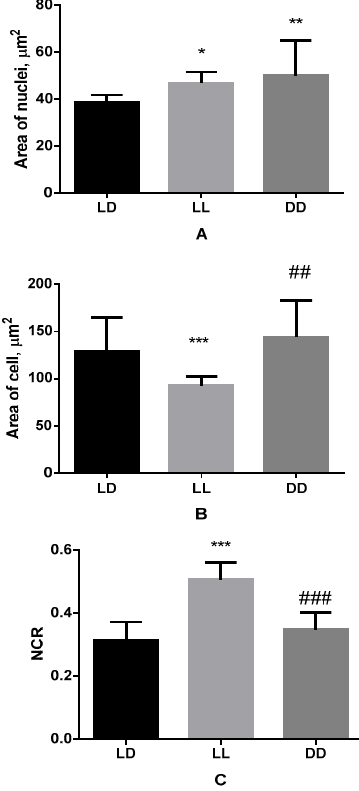
Figure 3. Influence of various lighting regimes on cell nuclei area ( A ), cell area ( B ) and nuclear-cytoplasmic ratio ( C ) of cells of B16 melanoma. * ( p ≤ 0.05); ** ( p ≤ 0.005), *** ( p ≤ 0.0005);—differences in comparison with the parameters of control group mice; ## ( p ≤ 0.005); ### ( p ≤ 0.0005)—differences in comparison with mice of LL group.